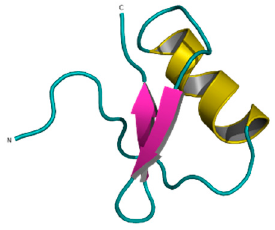
Figure 11. Ts6 toxin